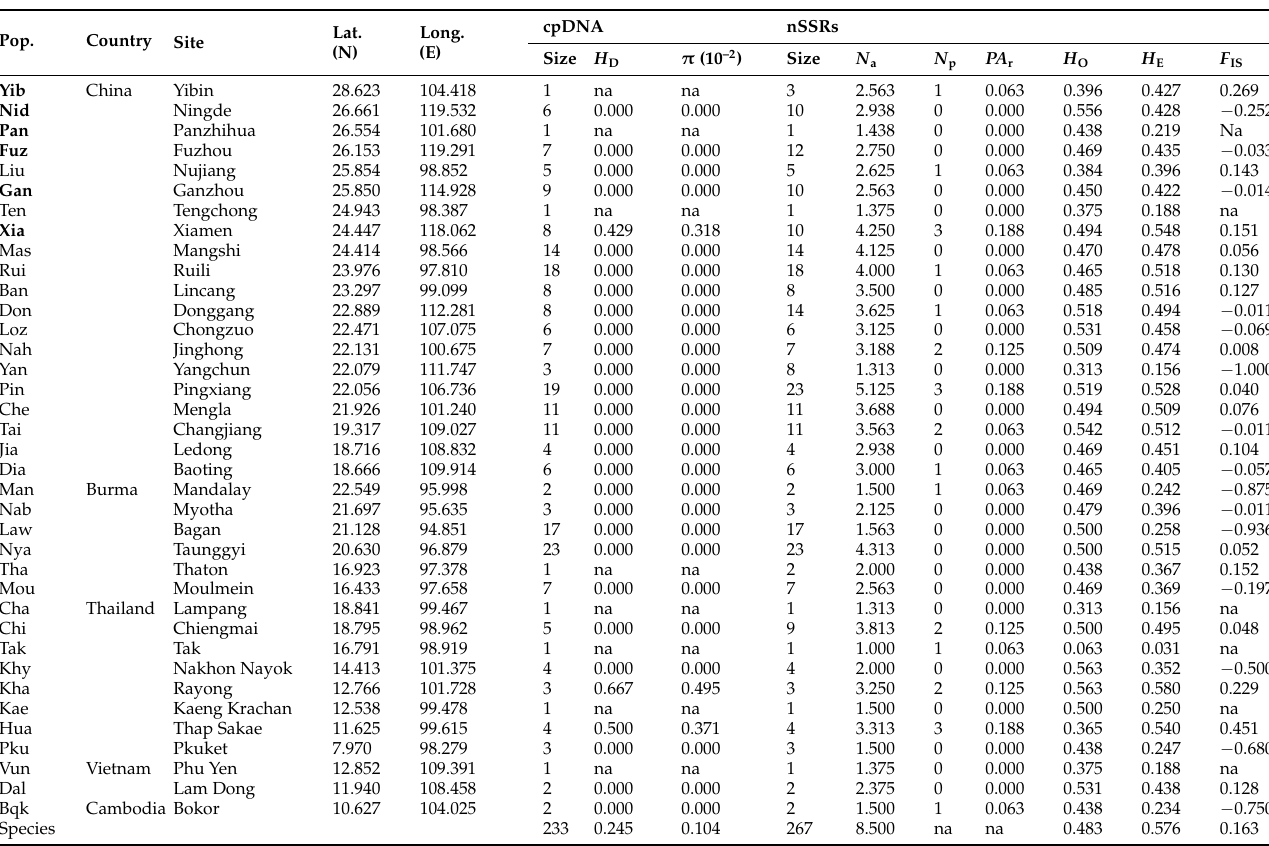
Table A1. Sampling information and genetic parameters of the 37 sampled Ficus altissima populations based on cpDNA psbA-trnH and 16 nSSRs.